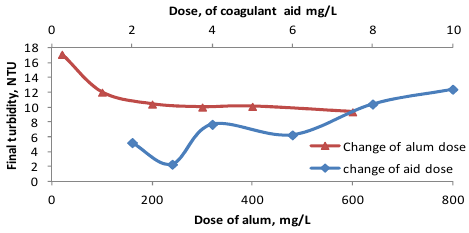
Fig.5. Optimization of alum and coagulant